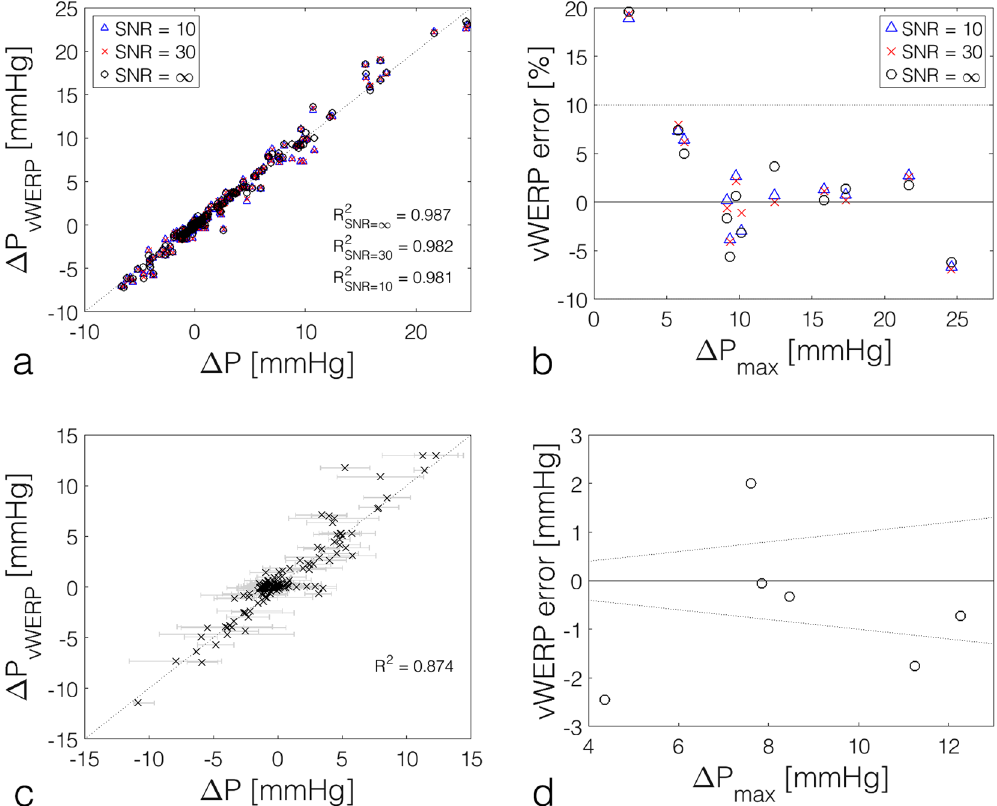
Figure 6. Cumulative analysis of ν WERP estimates in both in-silico and in-vivo evaluations. (a) Relative pressure estimations for patient-specific coarcted and dissected aorta, respectively, comparing ν WERP (y-axis) to simulated data (x-axis). (b) Relative error of ν WERP estimates at peak relative pressure for all evaluated inlet/ outlet planes in patient-specific coarcted and dissected aortas. Data for SNR = ∞ /30/10 is given by black circles, red crosses, and blue triangles, respectively. (c) Relative pressure estimation for the validation study, comparing ν WERP estimates (y-axis) to catheter measurements (x-axis). The distribution of the catheter data is given by gray bars, with ν WERP estimates superimposed by black crosses. (d) Absolute error of ν WERP estimates at peak relative pressure for the entire validation study cohort. Data for estimates against the mean of all catheter measurements is given by the black circles, and relative errors of ± 10% are given by the dashed black